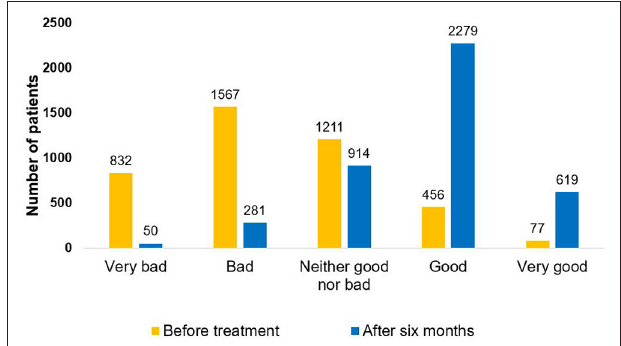
FIGURE 3 | Quality of life assessment. Quality of life was assessed prior to and 6 months after initiation of cannabis treatment ( p < 0.001). Assessment was done on 4,143 patients who responded twice to this